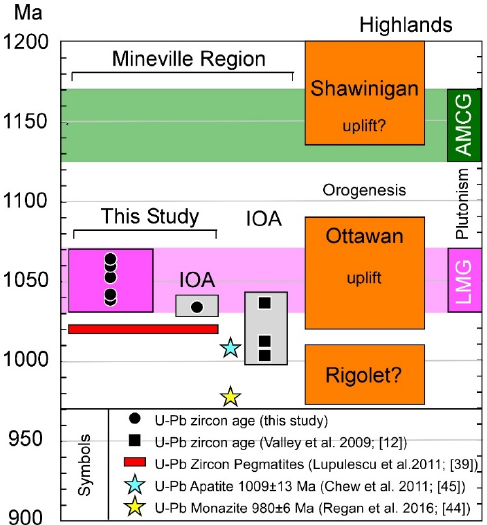
Figure 11. Summary of events recorded in the Eastern Adirondacks and regionally within the Adirondack Highlands.